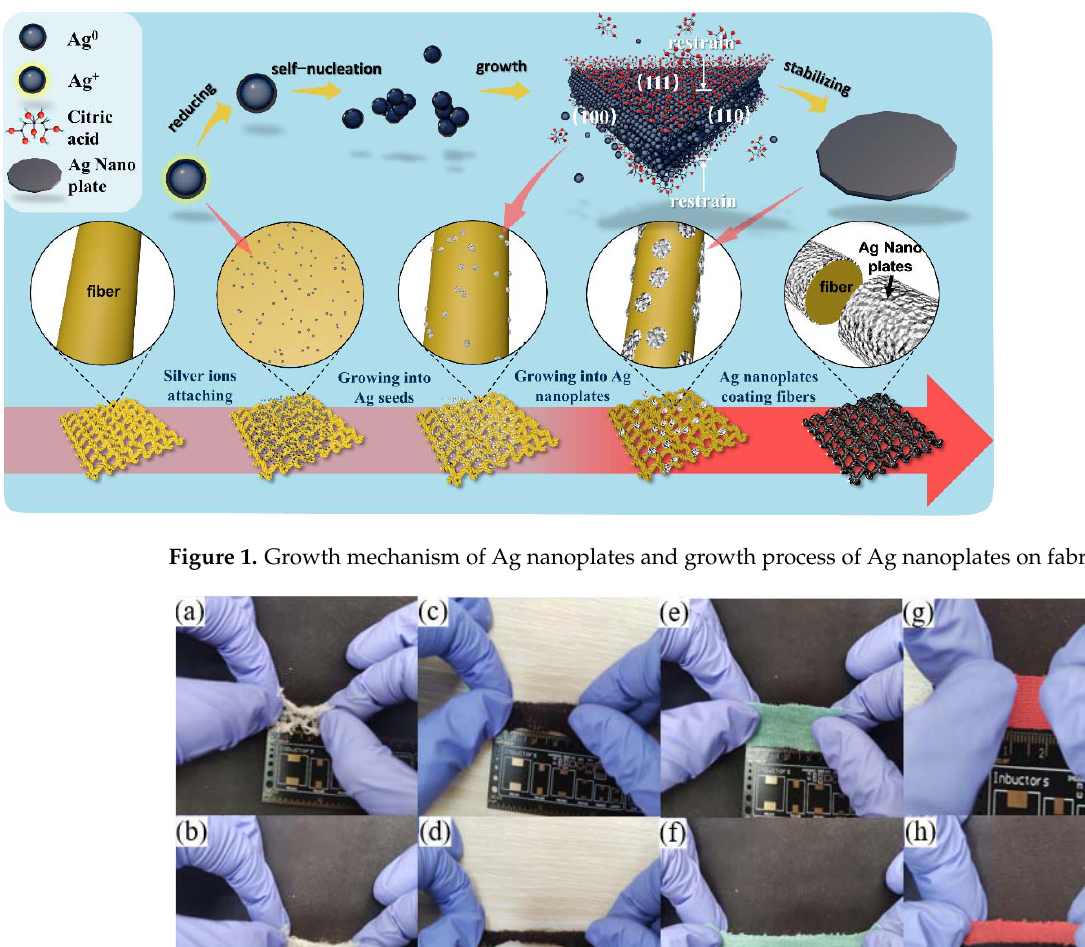
Figure 1. Growth mechanism of Ag nanoplates and growth process of Ag nanoplates on fabric.